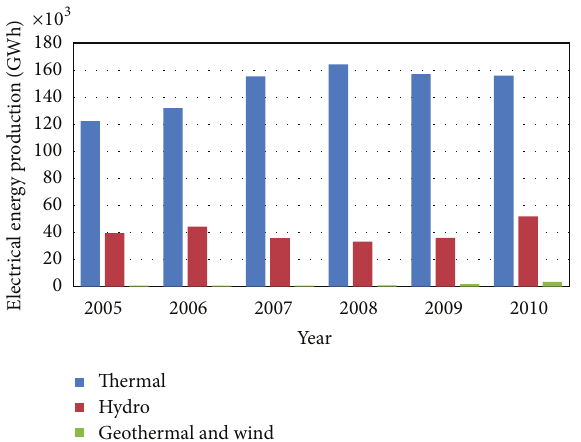
Figure 4: Turkey’s gross electrical energy production for the years 2005–2010.